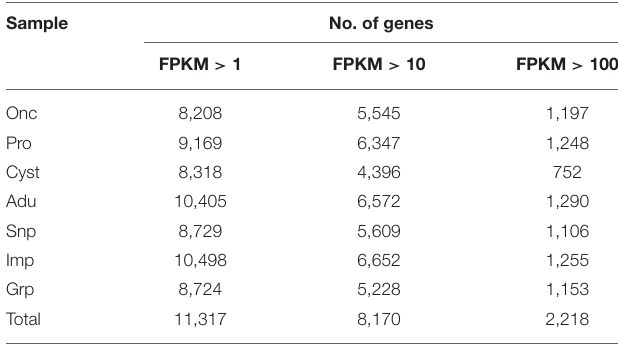
TABLE 3 | Statistics of expression genes in seven RNA-seq samples with FPKM > 1, FPKM > 10, and FPKM > 100.